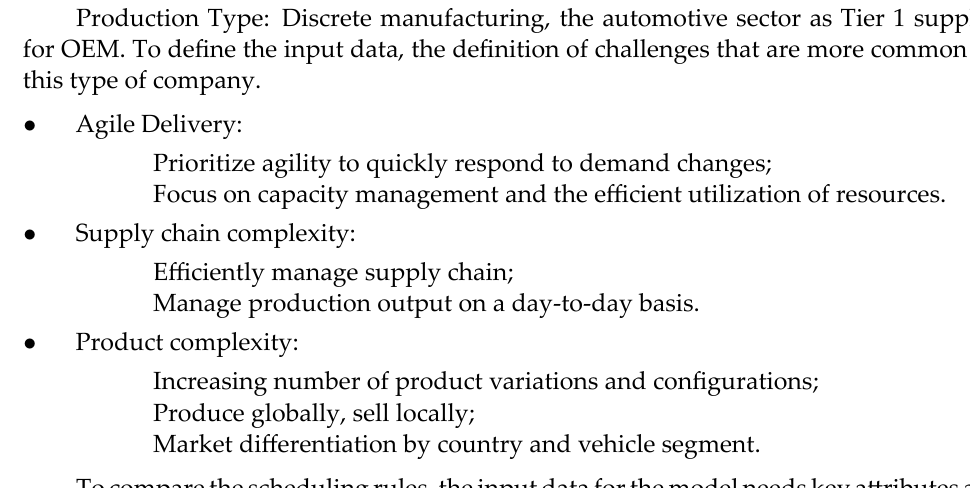
Table 2. Constrains model to create model for scheduling.